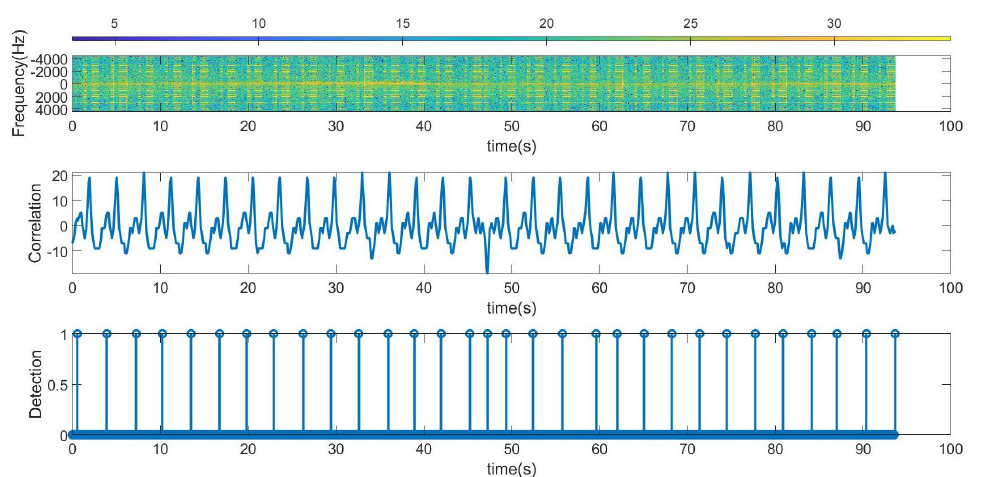
Figure 16. Measurement for a stationary scooter sending Barker codes of length 7 at a distance of 8 m. From top to bottom: raw spectrogram before CFAR processor, the signal at the output of the correlator and tag detection.